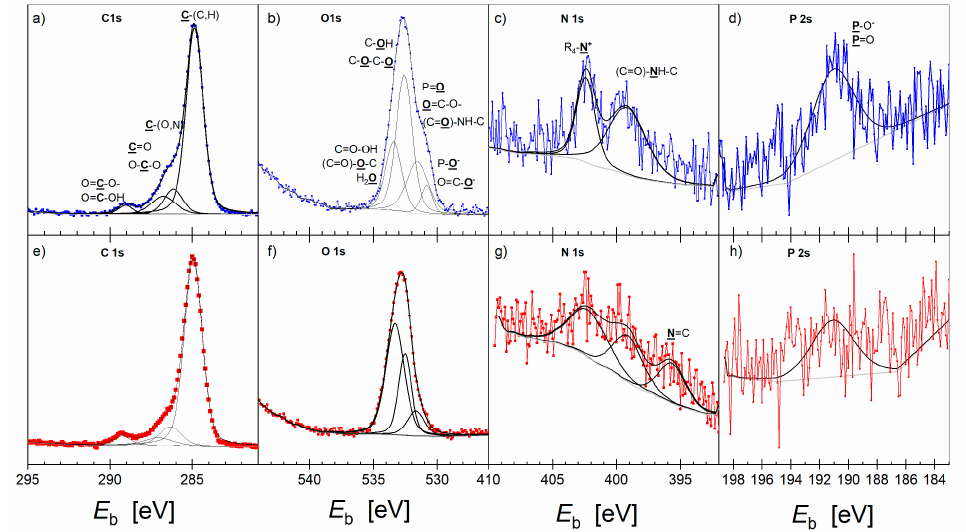
Figure 6. High-resolution C1s ( a , e ), O1s ( b , f ), N1s ( c , g ) and P 2s ( d , h ) XP spectra of the asymmetric